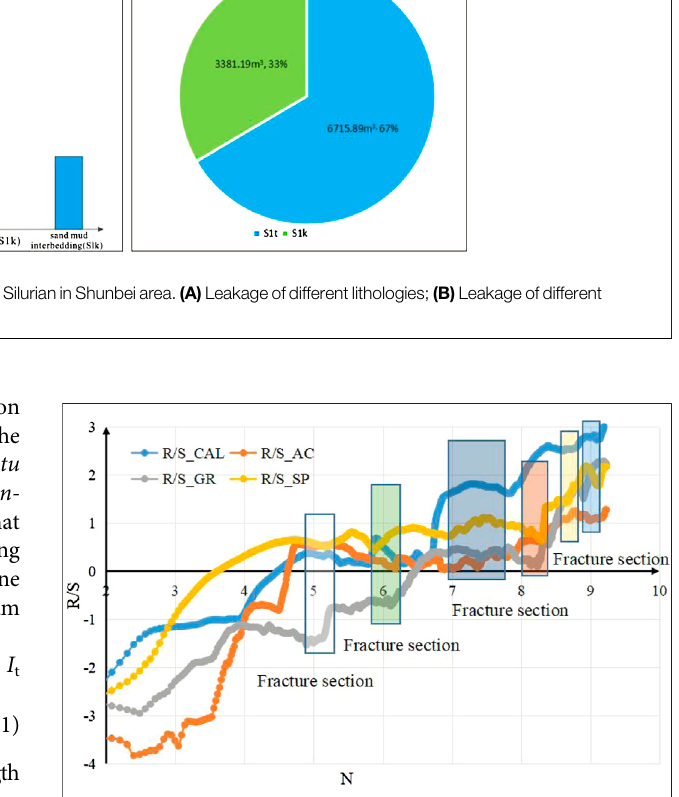
FIGURE 8 | Fracture interval identi fi cation based on R/S-FD method in Silurian of Well X in the study